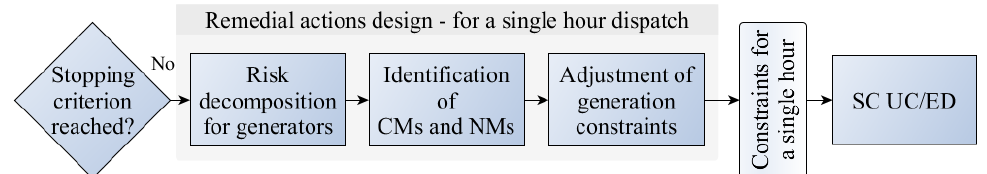
Figure 3. Detailed scheme of the remedial actions design process for a single hour result of the dynamic risk assessment from Figure